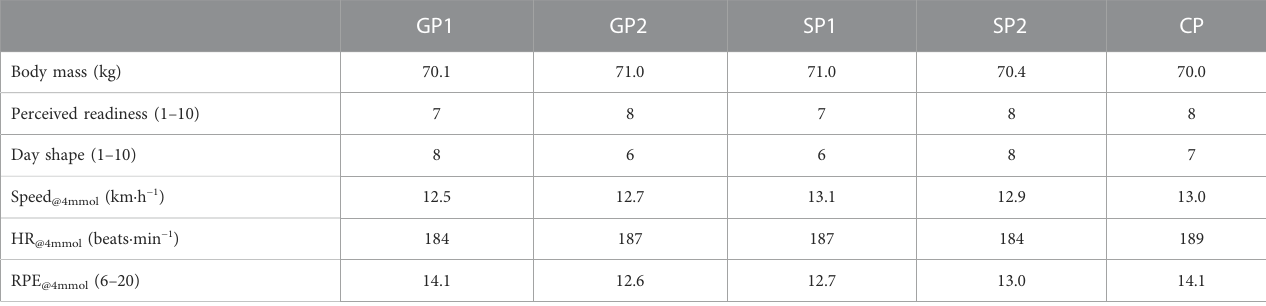
TABLE 5 Blood lactate pro fi ling in running at different time points in the season returning to world-class level in a male cross-country